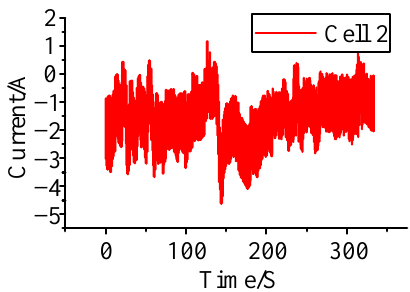
Figure 15. Lithium battery current change diagram. (Adjacent equalisation circuits and fuzzy control strategies)